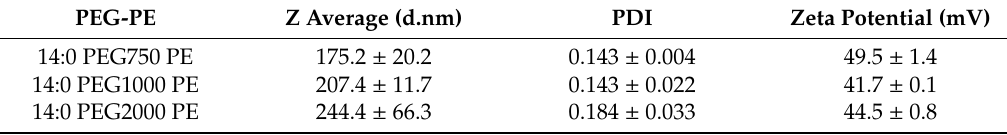
Table 4. Characterizations of MCLs by the cosolvent sonication method using di ff erent PEG-PE.